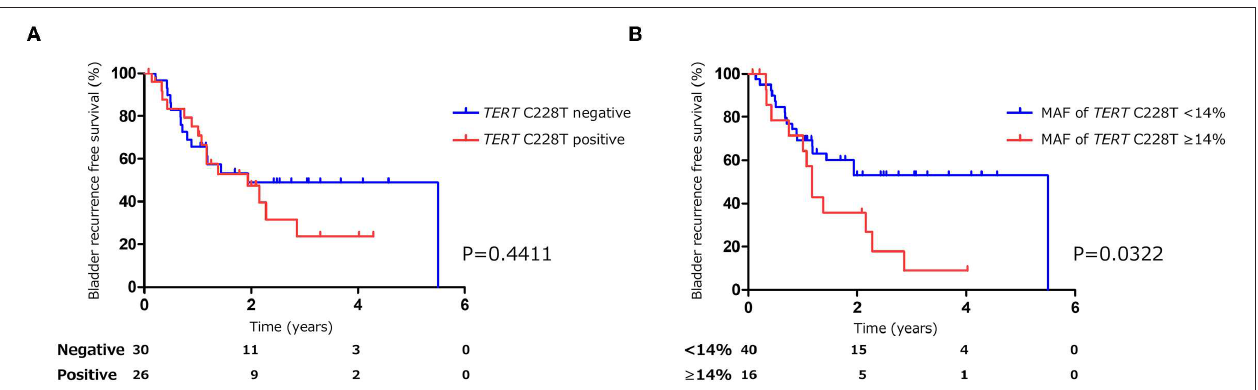
FIGURE 3 | Kaplan-Meier analysis of bladder tumor recurrence free survival of pre-TURBT group1 stratified by TERT C228T mutation (A) , and by mutant allele frequency (14%) of TERT C228T (B)